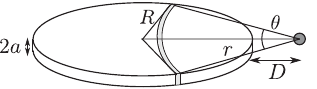
FIG. 5. Schematic of the coordinate system for calculating the potential on a point particle due to a disc composed of point scatterers. The point particle, which has radius a , is placed in plane with the disc (which has radius R and thickness 2 a ) and at a horizontal distance D from the edge of the